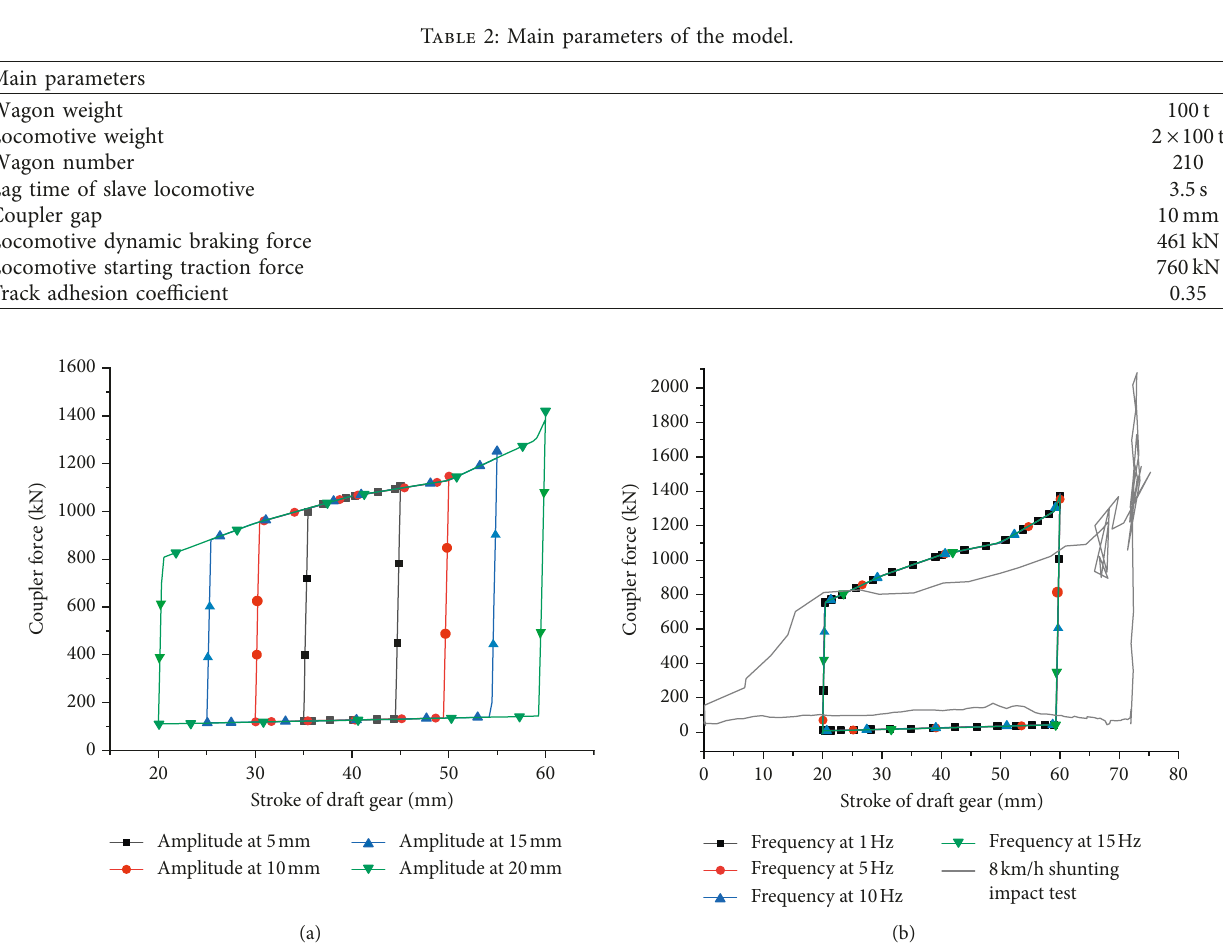
Figure 8: Bench test simulation with the lookup table model. (a) Bench test simulation at different amplitudes. (b) Bench test simulation at different frequencies.